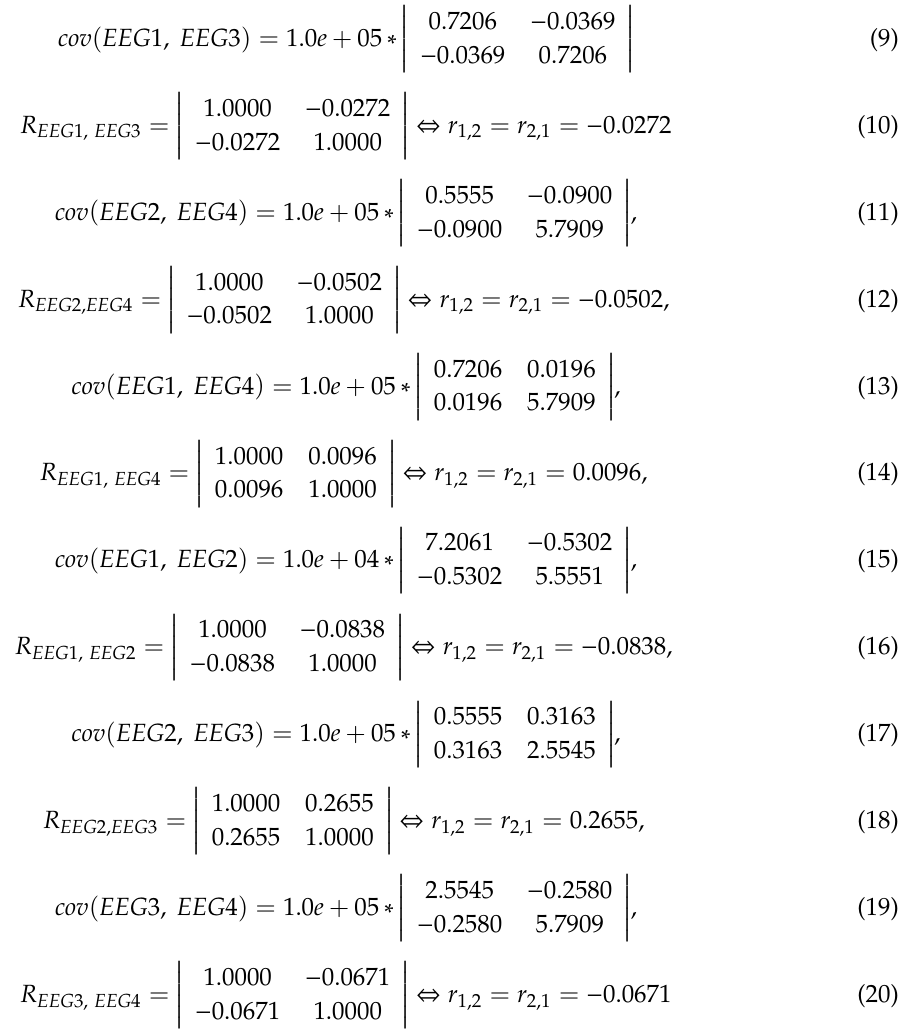
EEG4 signals in the Brainstorm application, it can be seen that the values for W EEG1 = 0.9378, W EEG2 = 0.9236, W EEG3 = 0.9133, and W EEG4 = 0.8299, are very close to 1, which means that the signals have a distribution close to the normal